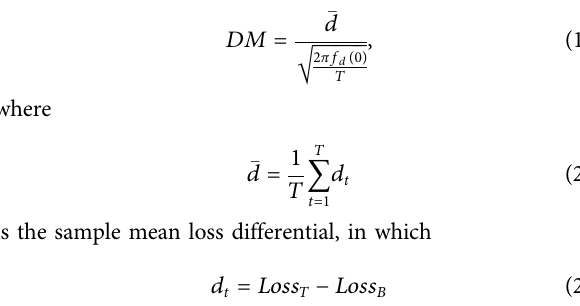
is the relative loss function, where Loss T and Loss B are the loss function of predicted errors of test model T and benchmark method B at time t, respectively.